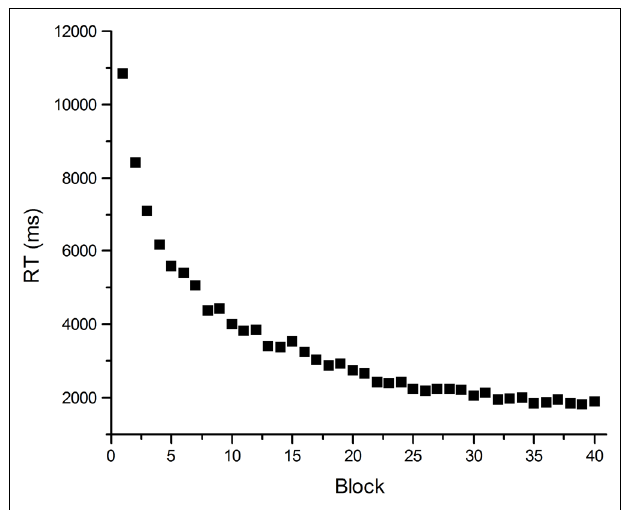
FIGURE 2 | Mean RT data from practice on an arithmetic task. Participants ( N = 40) solved an equation [( x 2 − y )/2 = A ) with eight repeating ( x , y ) pairs, determining whether A was “odd” or “even” for each pair, for 40 blocks of eight